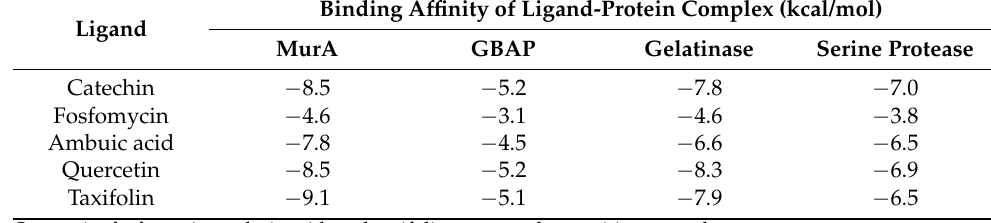
Table 4. The binding affinity of catechin ( 1 ) and positive controls. Ligand